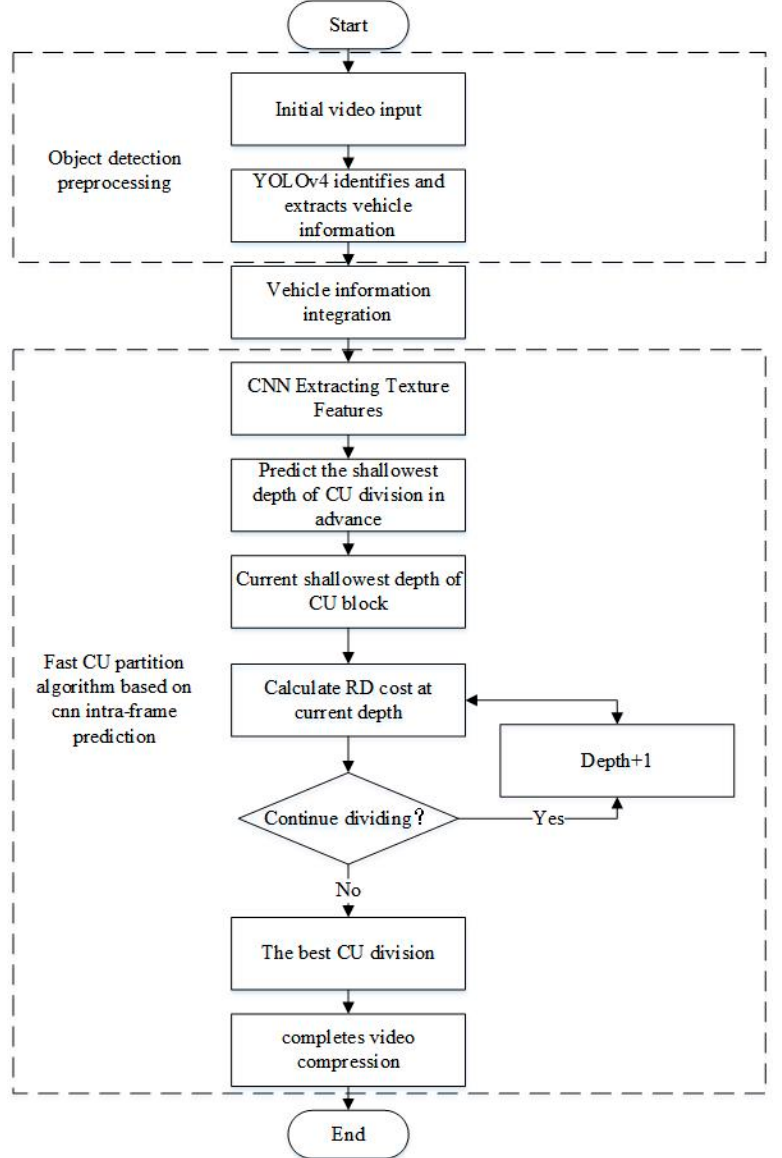
Figure 1. Flow chart of expressway video depth compression method based on content value.